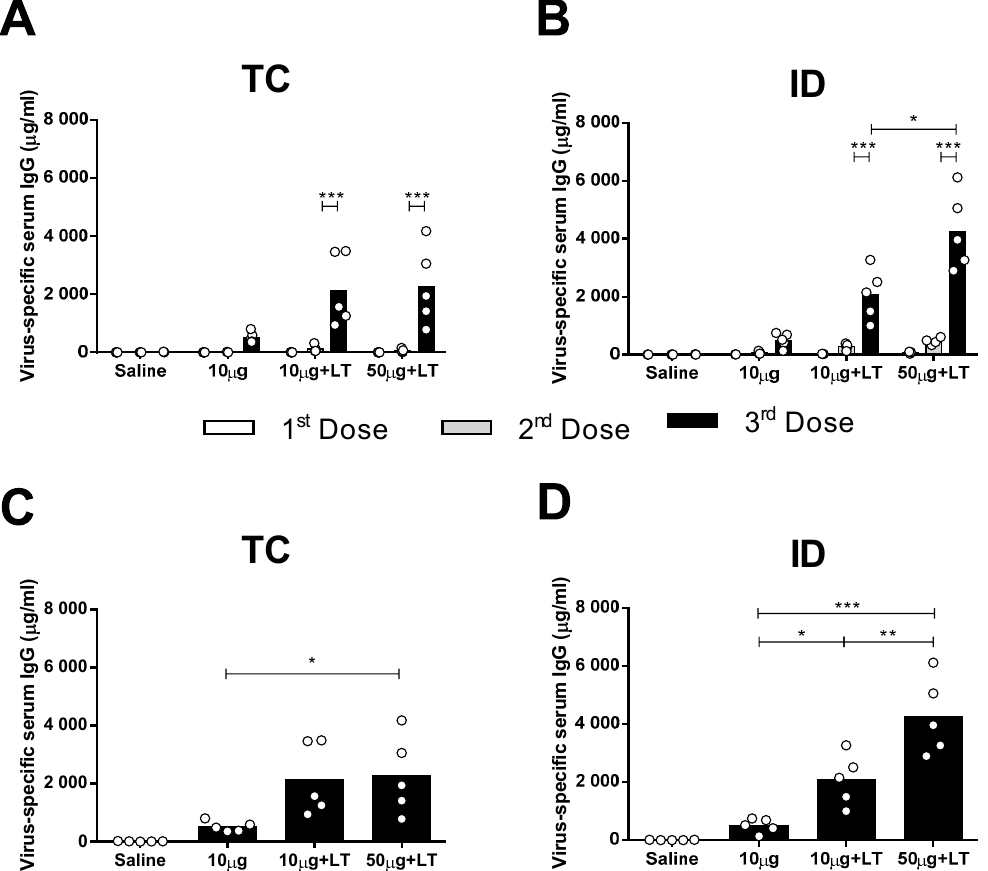
Figure 1. Serum IgG responses elicited in mice immunized with type 2 Dengue virus particles (DENV2) through transcutaneous (TC) or intradermal (ID) administration routes. Concentrated virus particles (10 or 50 µ g protein / dose) were administered alone or with heat-labile toxin (LT) as adjuvant (10 µ g / dose) in BALB / c mice ( n = 5). The immunization protocol consisted of 3 doses administered with a two week interval. Both TC as well as ID inoculations were administered in the dorsum of the animals, as described in the Material and Methods section. ( A , B ) Dose-dependent anti-DENV serum IgG responses elicited in mice following administration via TC ( A ) or ID ( B ) routes. Columns represent mean IgG concentration values + SD. ( C , D ) Individual serum anti-DENV2 IgG responses in mice submitted to TC ( C ) or ID ( D ) immunizations measured two weeks after the last dose. Statistical analysis was performed with a two-way ANOVA test associated with Bonferroni’s post-test. * p < 0.05, ** p < 0.01, *** p < 0.001. Representative results of 3 independent